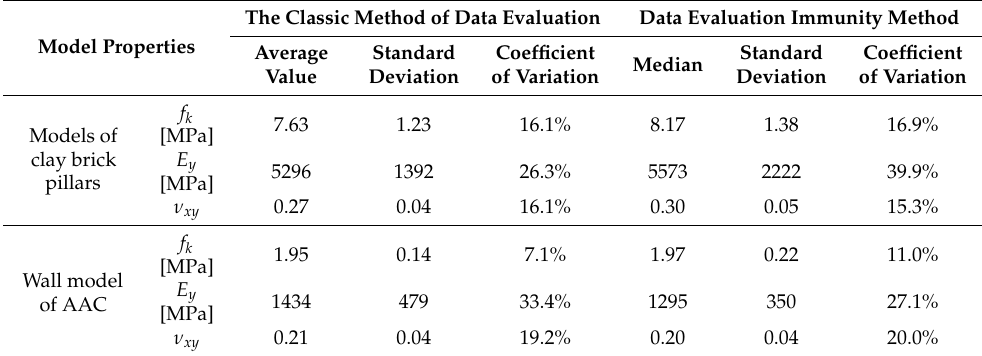
Table 6. Value estimators and standard deviation of compressive strength, modulus of elasticity, and Poisson’s ratio for pillar and masonry wall